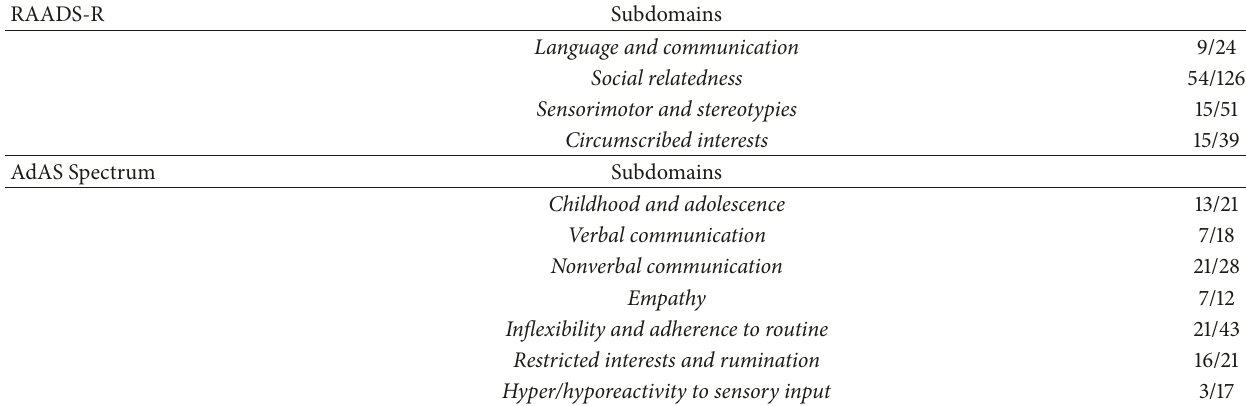
Table 1: The patient’s scores on the RAADS-R and AdAS